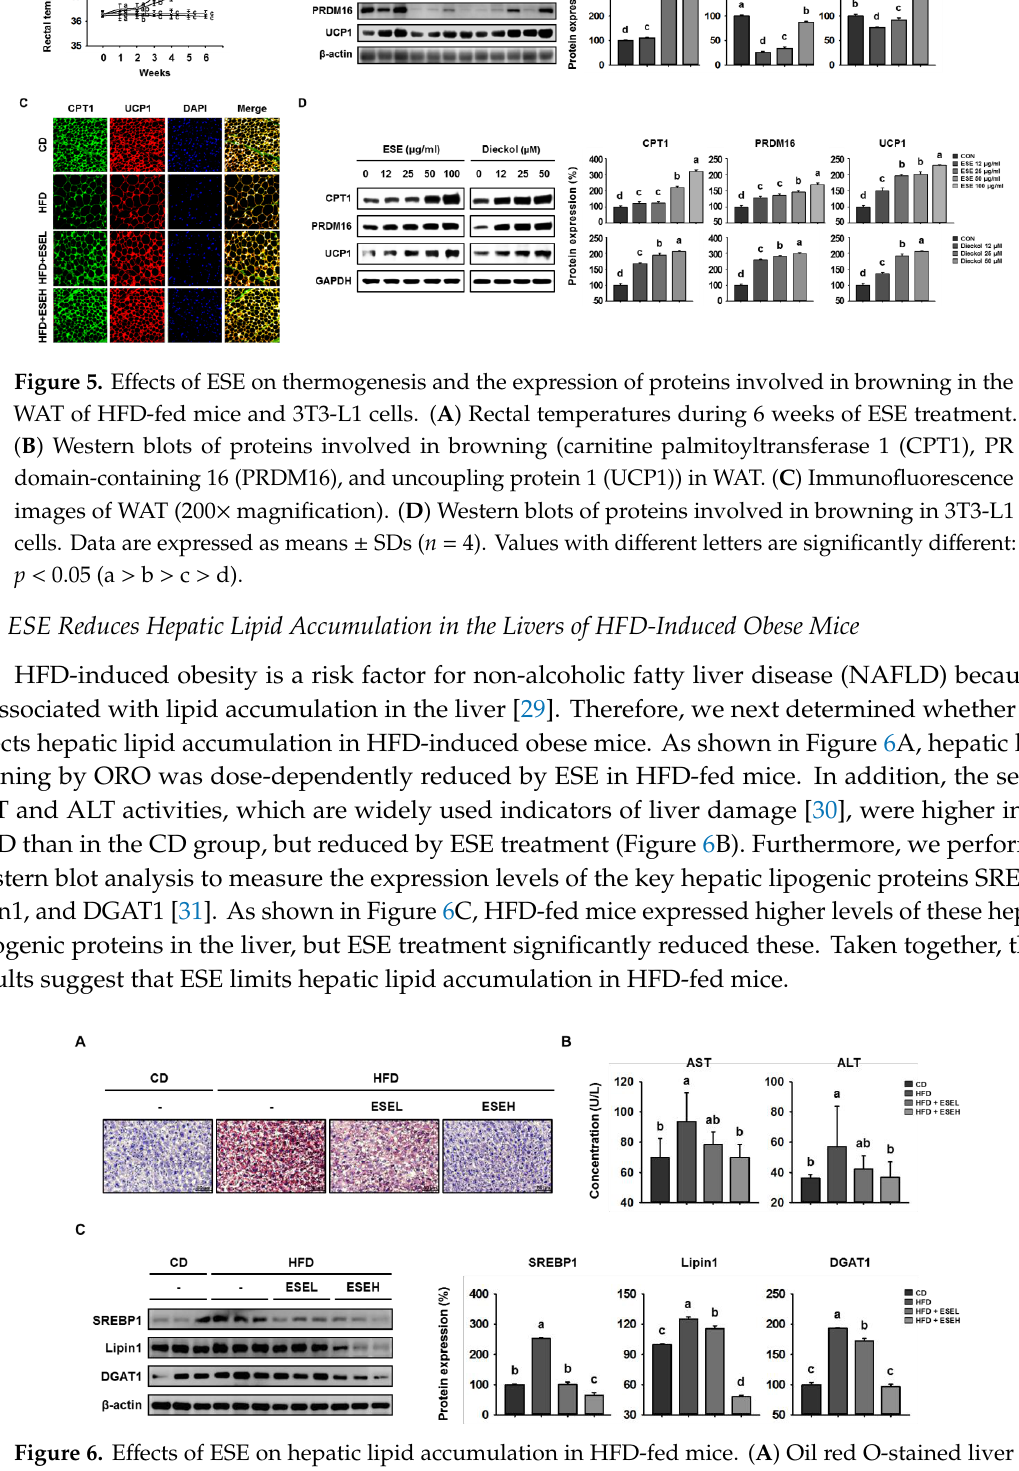
Figure 6. Effects of ESE on hepatic lipid accumulation in HFD-fed mice. ( A ) Oil red O-stained liver sections from mice. Scale bar: 50 µ m. ( B ) Serum aspartate transaminase (AST) and alanine transaminase (ALT) activities in HFD-fed mice. ( C ) Western blots of hepatic lipogenic protein expression (SREBP1, Lipin1, and DGAT1). Data are expressed as means ± SDs ( n = 4). Values with di ff erent letters are significantly di ff erent: p < 0.05 (a > b > c > d).